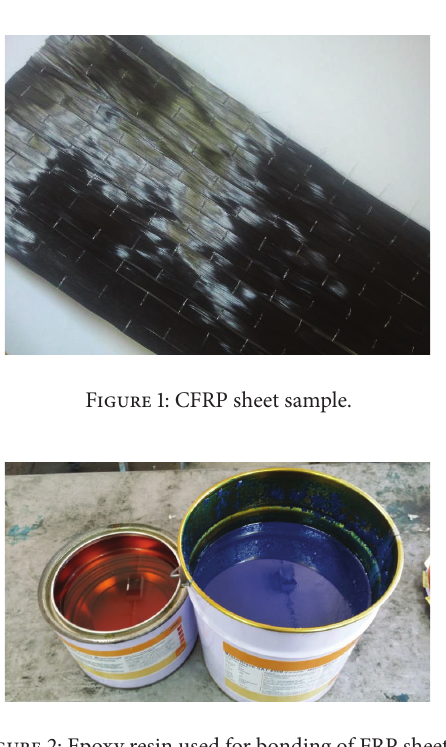
Figure 2: Epoxy resin used for bonding of FRP